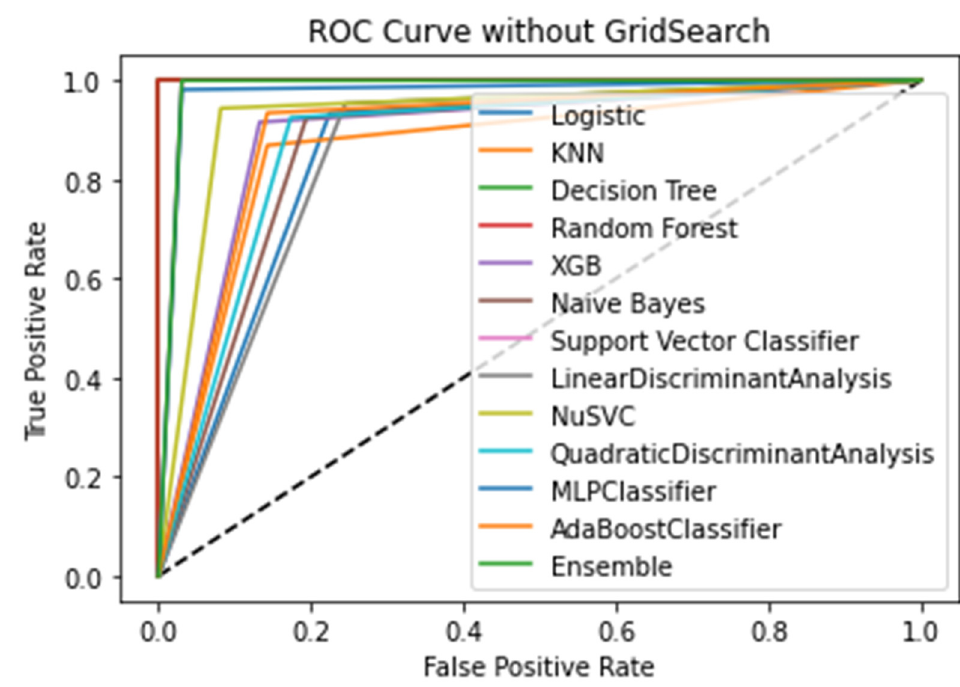
Figure 30. The performance of ML classifier using Staking CV Classifier. Figure 31. The performance of ML classifier using Staking CV Classifier ROC_AUC. Table 4. The performance of ML classifier using Staking CV classifier. Table 4. The performance of ML classifier using Staking CV